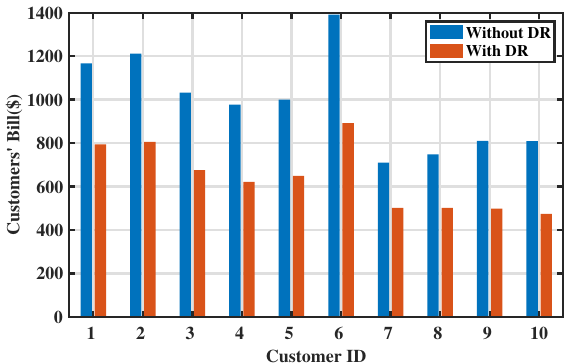
Figure 8. Customers’ daily bill with and without DR.